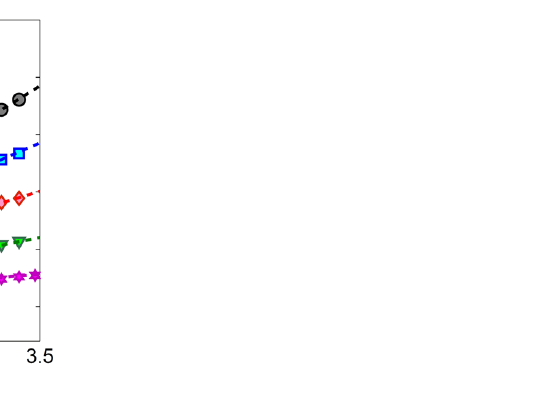
Figure 9. Short term evolution of the Hamming distance averaged over 2000 realizations for systems with one refractory time step, N = 40000, and different values of λ = 1.0, 1.2, 1.4, 1.6, 1.8. Linear fits are indications of power-law